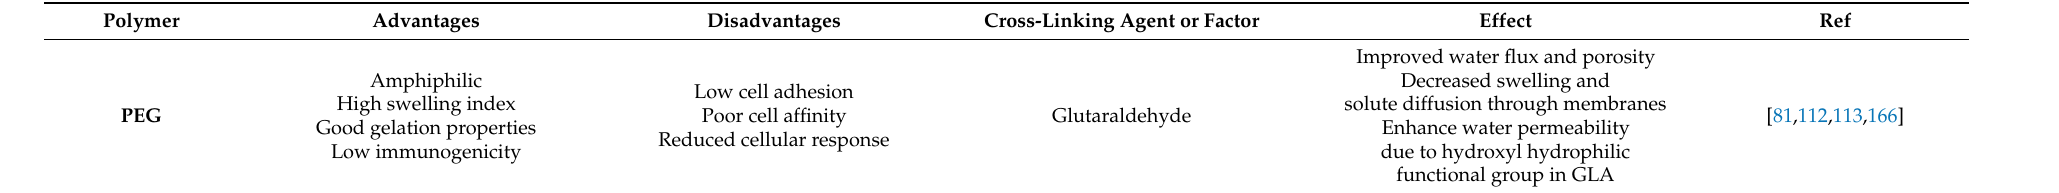
Table 3. A summary of synthetic polymers, advantages, disadvantages, cross-linking agents or factors used and their